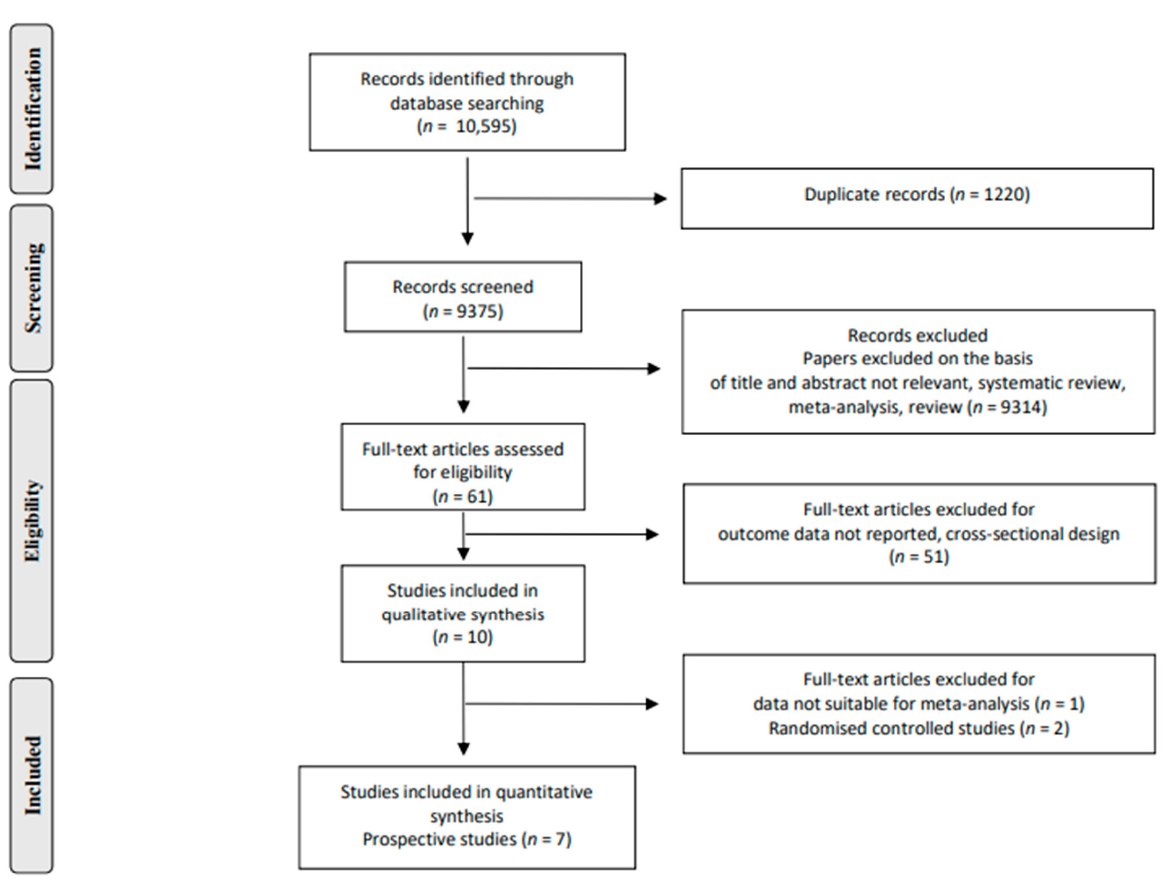
Figure 1. Stepwise procedure for selection of the studies.